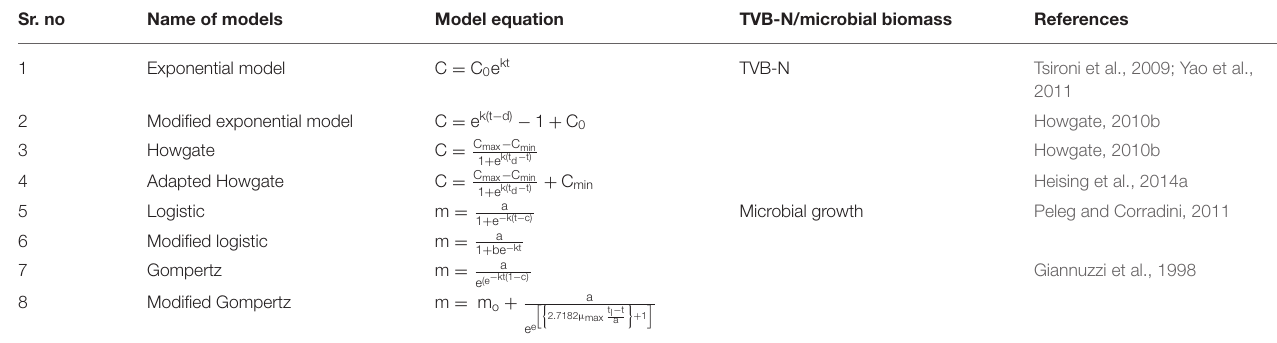
TABLE 1 | Empirical models consider for TVB-N and microbial biomass modeling. Sr.